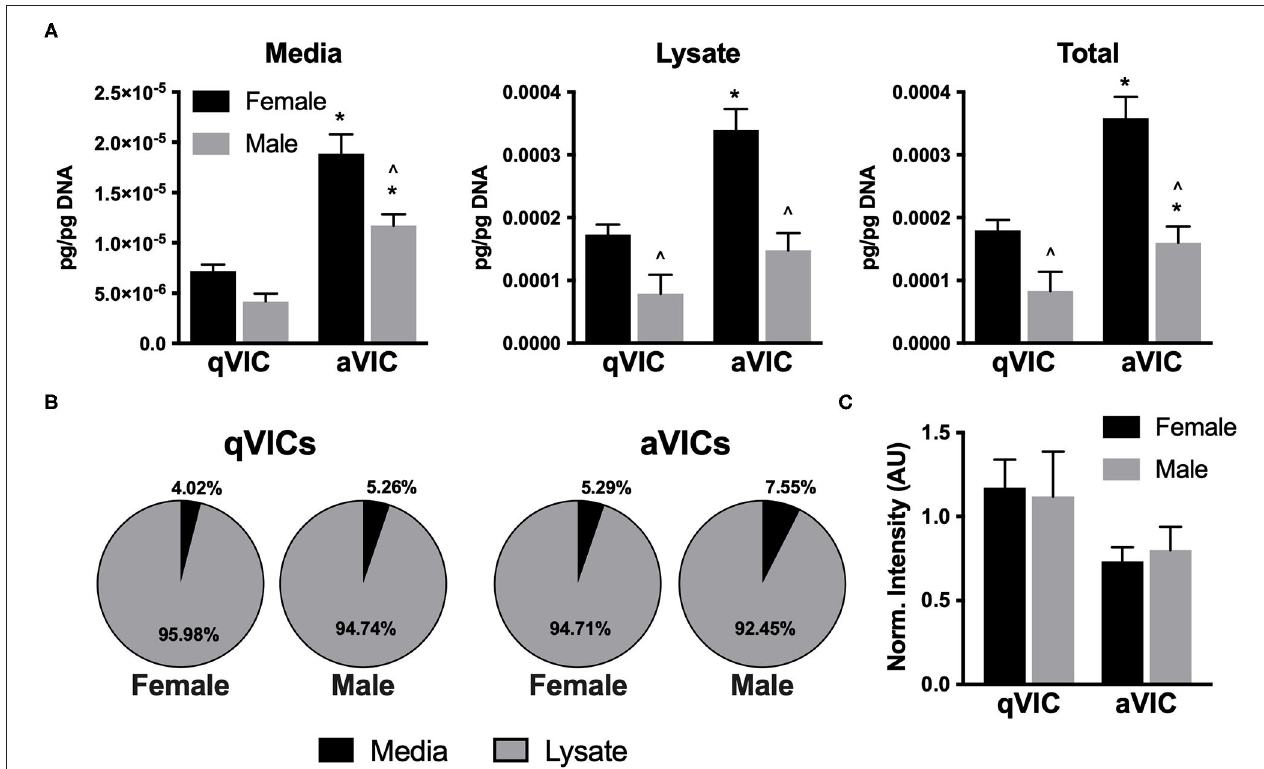
FIGURE 5 | Production of anti-angiogenic factors by VICs. (A) Production and (B) distribution of thrombospondin-2 (TSP2) in VIC cultures. (C) Western blot quantification of chondromodulin-1 in VIC lysates. * p < 0.05 vs. sex-matched qVIC level; ∧ p < 0.05 vs. female VIC of same phenotype by two-way ANOVA with Tukey’s post hoc test. N = 3 pigs per sex, n = 3 wells per